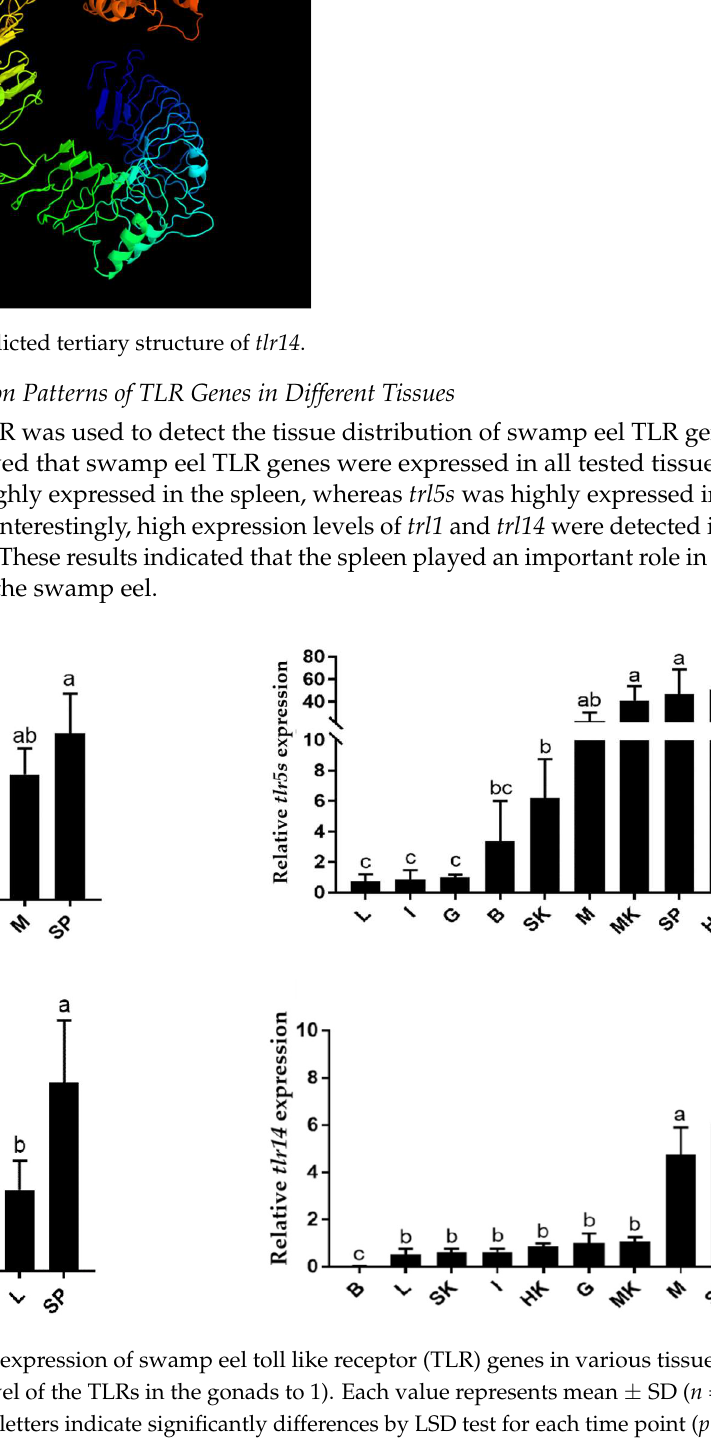
B: kidney; B: blood.